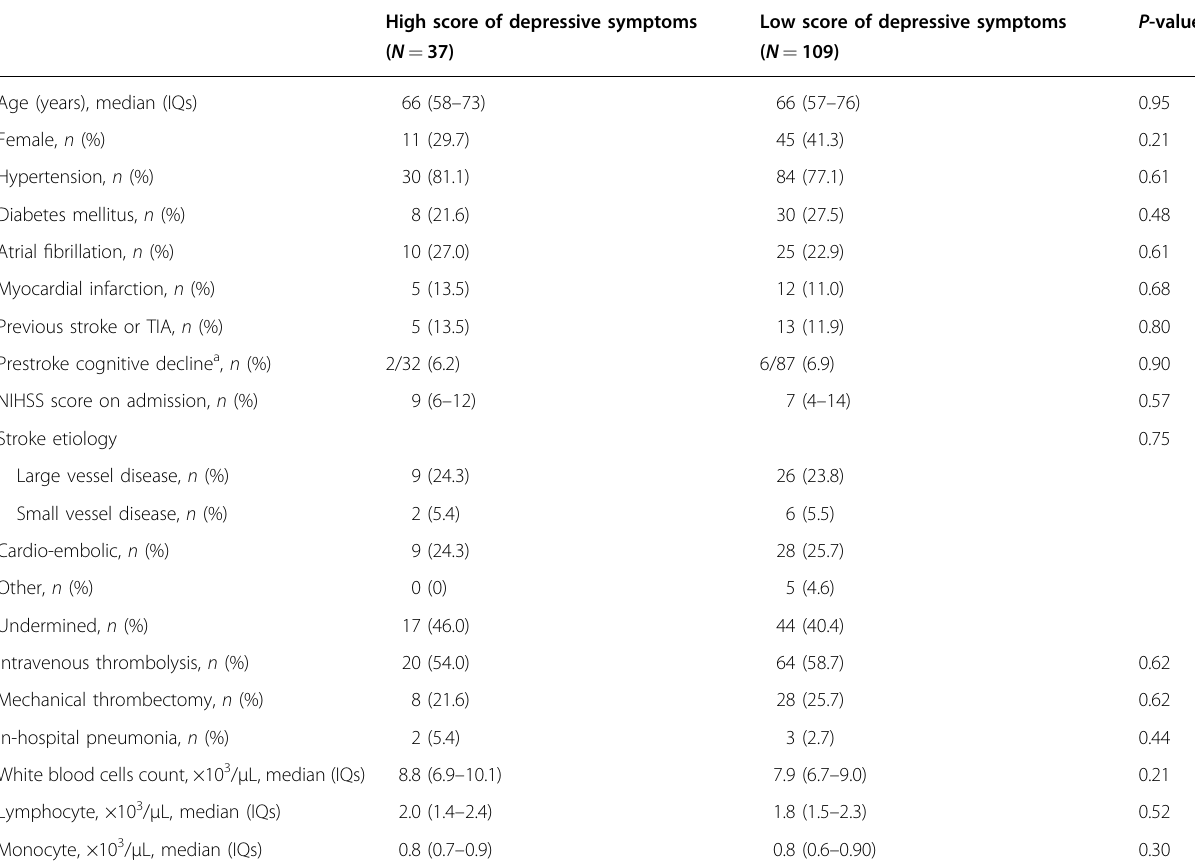
Table 2 Baseline characteristics of patients with high and patients with low depressive symptoms score at 3